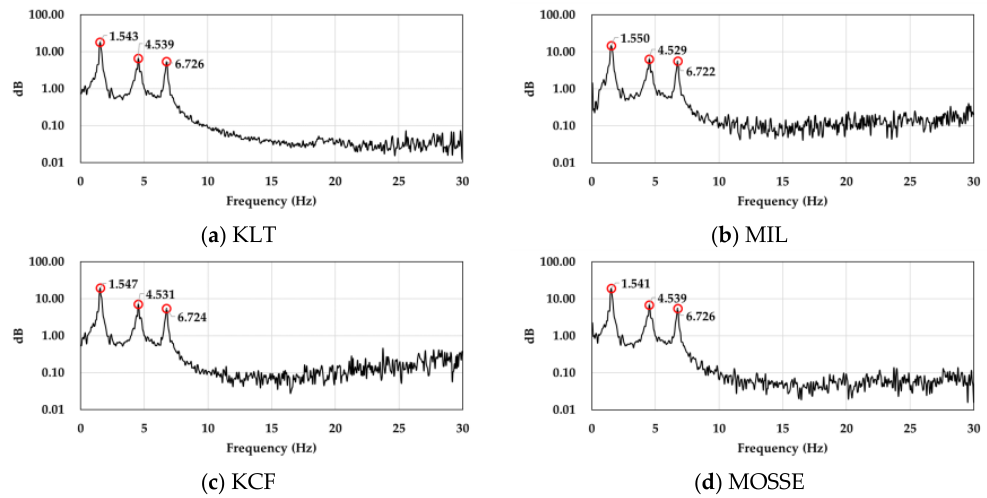
Figure 9. Comparison of the transfer function using different object tracking algorithms. Table 2. The natural frequency for different object tracking algorithms.